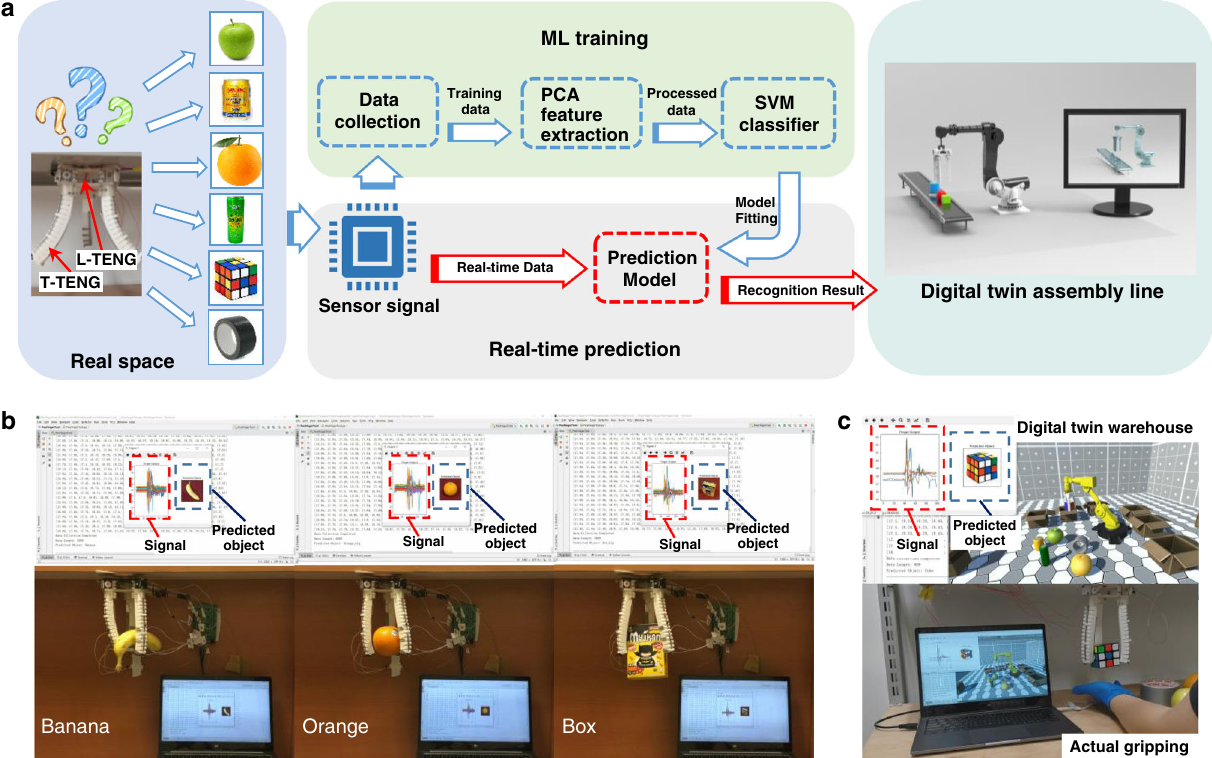
Fig. 6 The length TENG (L-TENG) and tactile TENG (T-TENG) sensors integrated digital twin unmanned warehouse system with machine learning (ML) technology. a The process fl ows from sensory information collection to ML training and real-time prediction in digital twin system, e.g., digital twin assembly line. The principal component analysis (PCA) is implemented to extract the data feature for ML training based on support vector machine (SVM). b Real-time gripped object prediction system. c The system interface integrated with object recognition and its digital twin warehouse